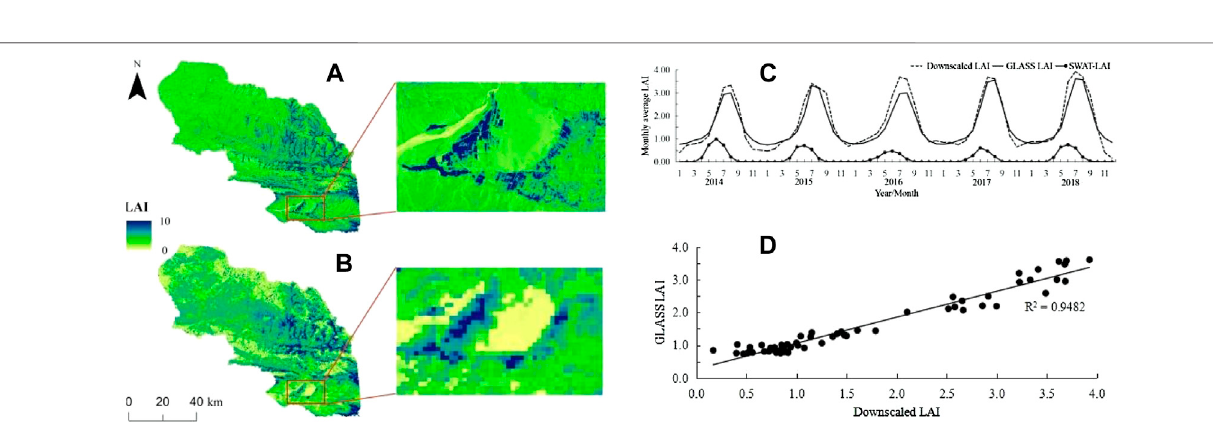
FIGURE 5 | The sensitive parameters for the original (A) and modi fi ed (B) Soil and Water Assessment Tool (SWAT) models.